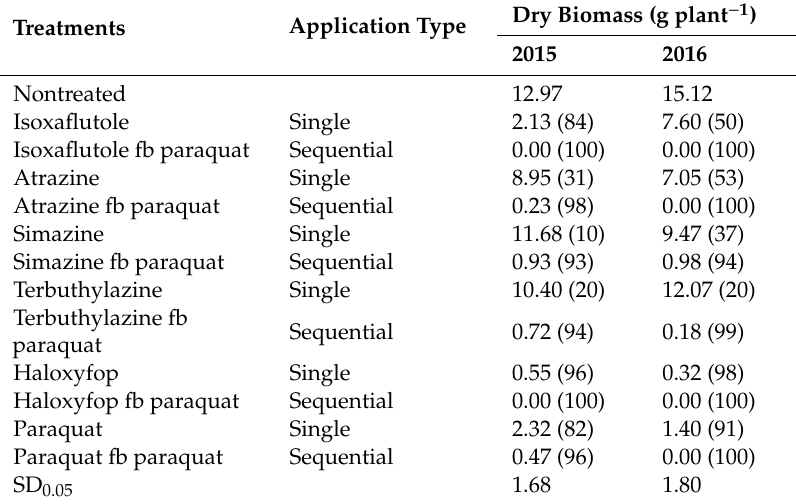
Values in parentheses are percentage control relative to nontreated. Abbreviations: fb = followed by 2nd application of herbicide 7 days later; LSD, least significant di ff erence at the 5% level of significance